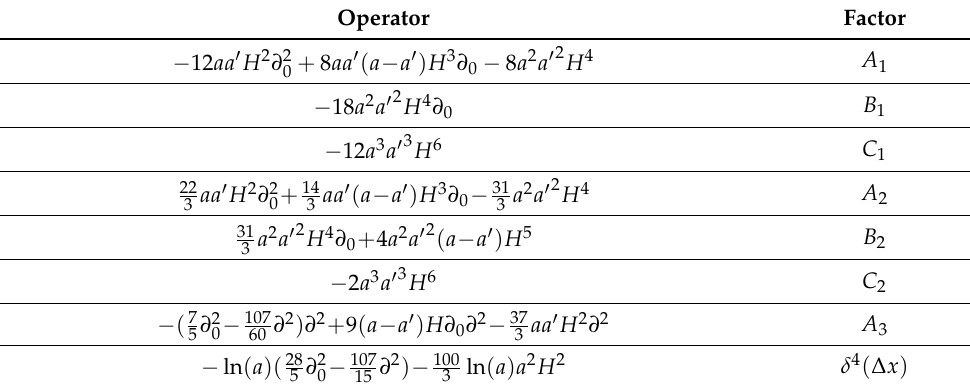
Table 10. Contributions for 3 ( iT 7 + iT 8 )+ iT 12 +( iT 16 + iT 17 ) . Each tabulated term must be multiplied by κ 2 32 π 3